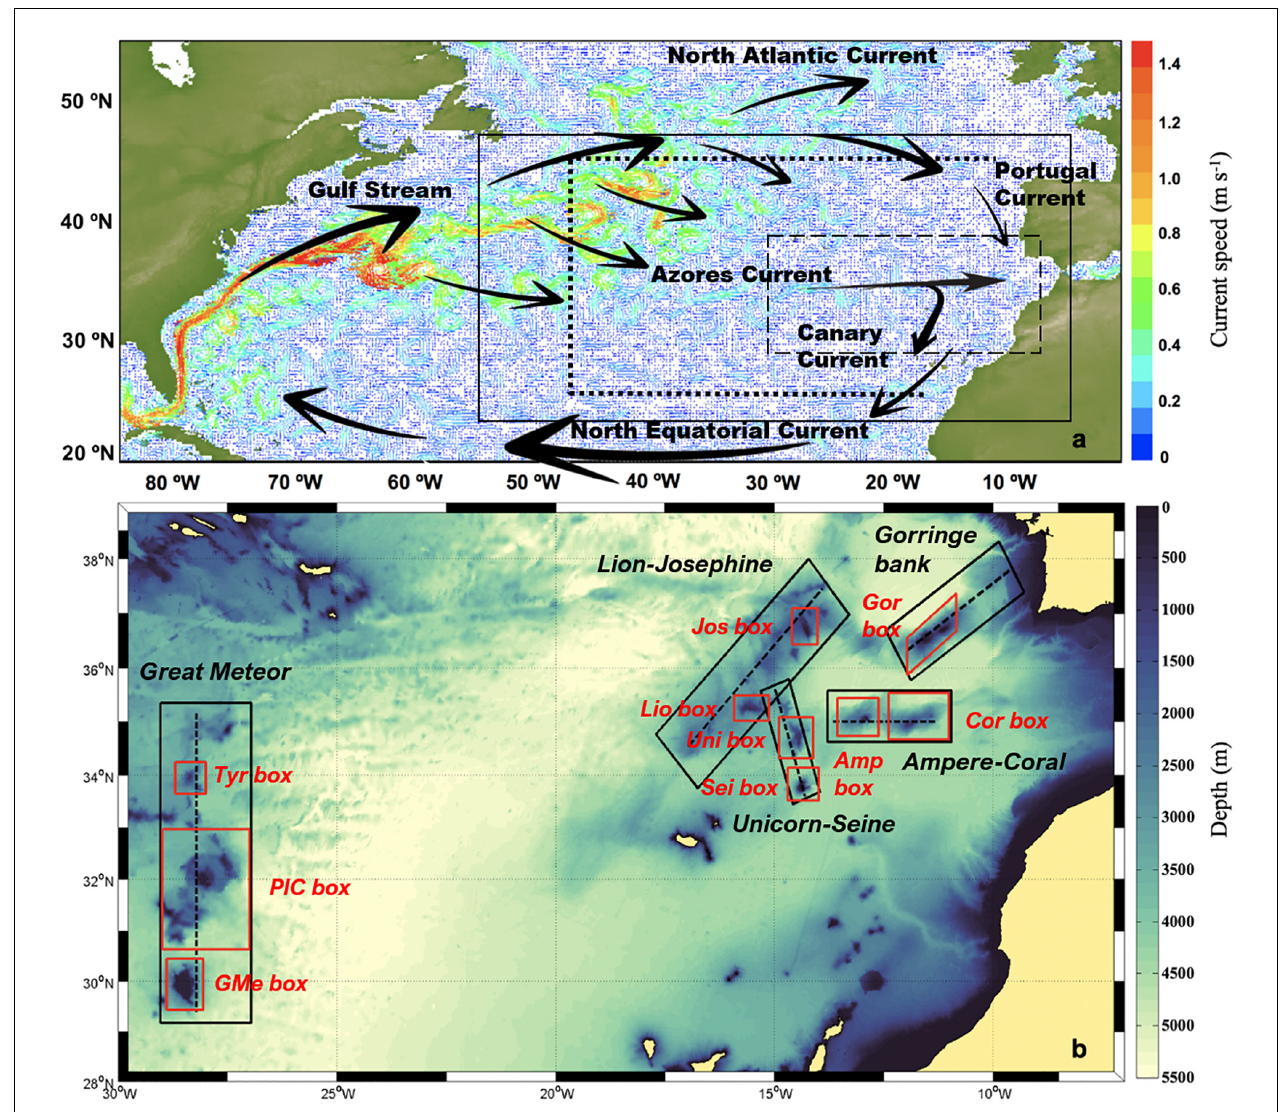
FIGURE 1 | (a) Representative map of the study area that includes the North Atlantic Subtropical Gyre and its associated currents: the Gulf Stream, the North Atlantic Current, the Portugal Current, the Azores Current, the Canary Current, and the North Equatorial Current. The solid line defines the HYCOM domain. The dotted lines represent the release boundaries for the particle retention experiment. (b) Zoomed-in view of the area that contains the seamounts under study [the dashed line on panel (a) ]. The dashed lines represent the release lines for the reverse particle experiment. The black boxes represent the sink boxes for the particle retention experiment. The red boxes represent the connectivity polygons defined for the connectivity